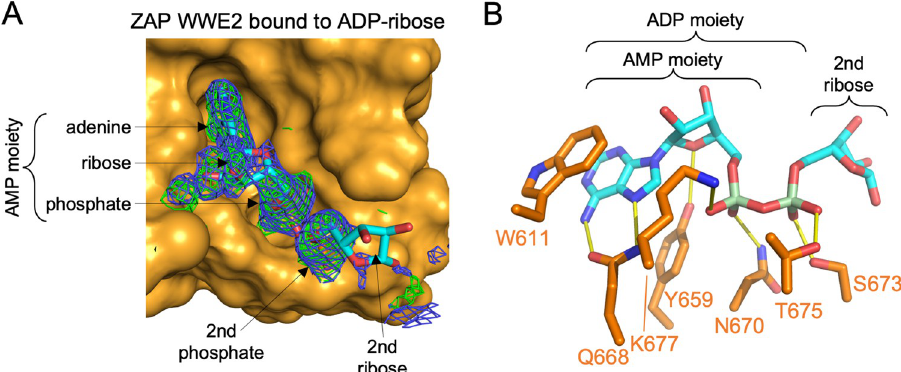
Fig 4. Structure of ZAP-CD in complex with ADPr. (A) Surface representation (orange) of the ZAP WWE2 pocket with the bound ADPr in stick representation (cyan), in the same orientation as Fig 3B, right panel. Blue mesh shows the 2mFo-DFc map for the ligand after refinement, contoured at 1 σ . Green mesh shows the unbiased positive mFo- DFc densities prior to placement of ADPr, contoured at 2.5 σ . (B) Details of the binding interaction, with ZAP residues shown in orange and the ADPr carbon atoms in cyan. Phosphate atoms are in pale green. Hydrogen bonds are in yellow.